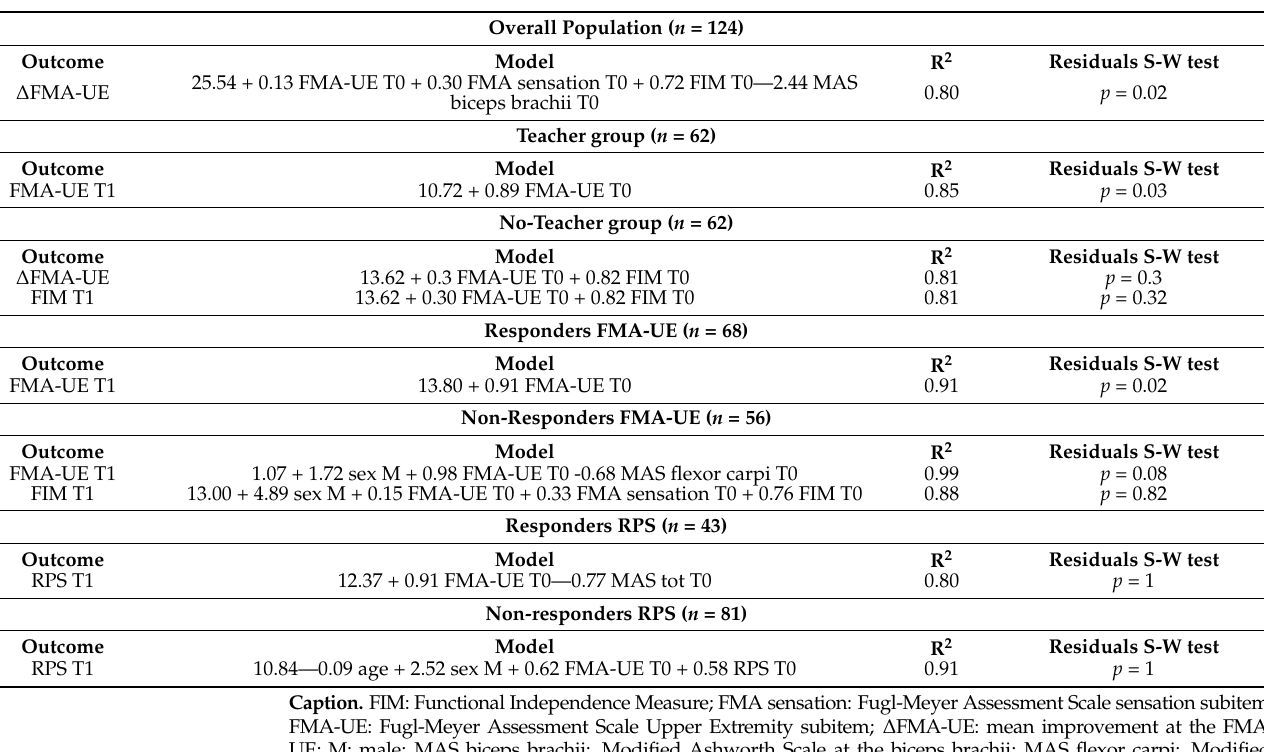
Table 3. Generalized Linear Model with good variability explained, for the overall sample and subgroups.